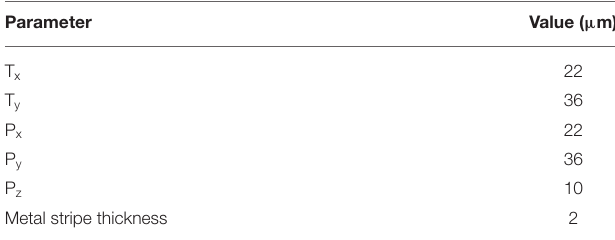
Table 1 . Parameters such as P x , P y , and P z are the dimensions of TABLE 1 | The optimized physical dimensions of the proposed structure and the periodicity of the periodic elements.